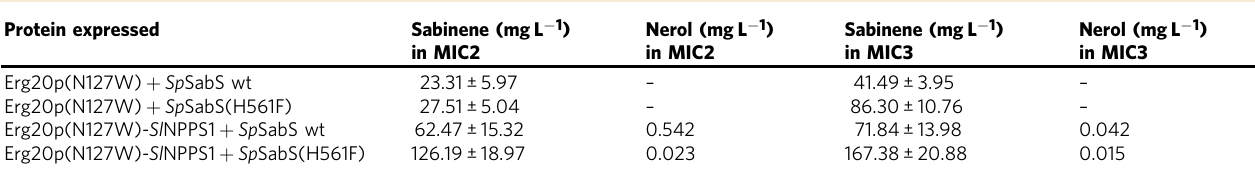
Table 3 Production of sabinene in semi-batch conditions Protein